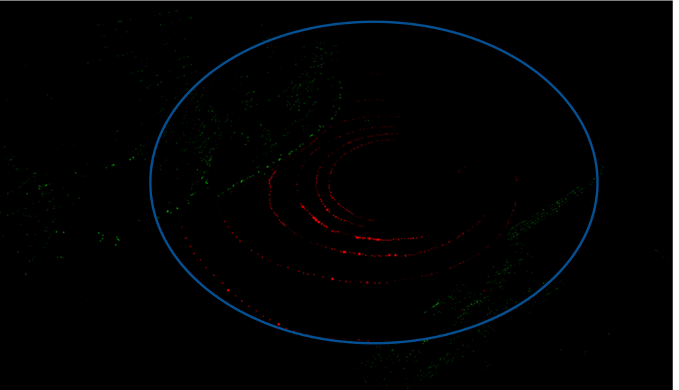
Figure 7. Ground recognition. Red points represent the ground point; green points represent the rest.